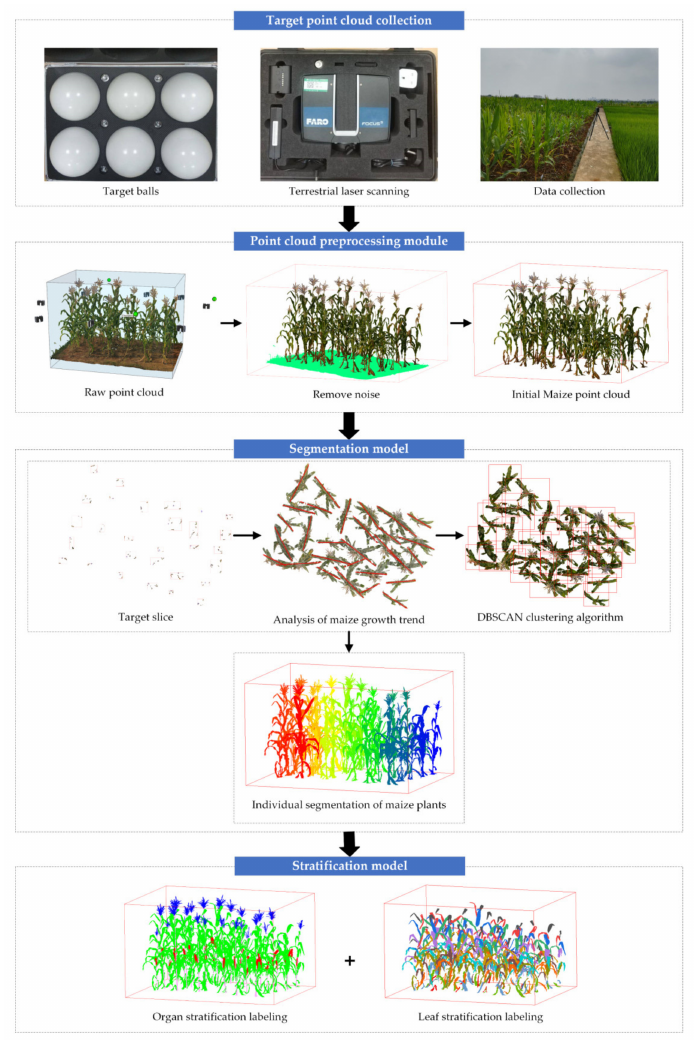
Figure 2. Research technology